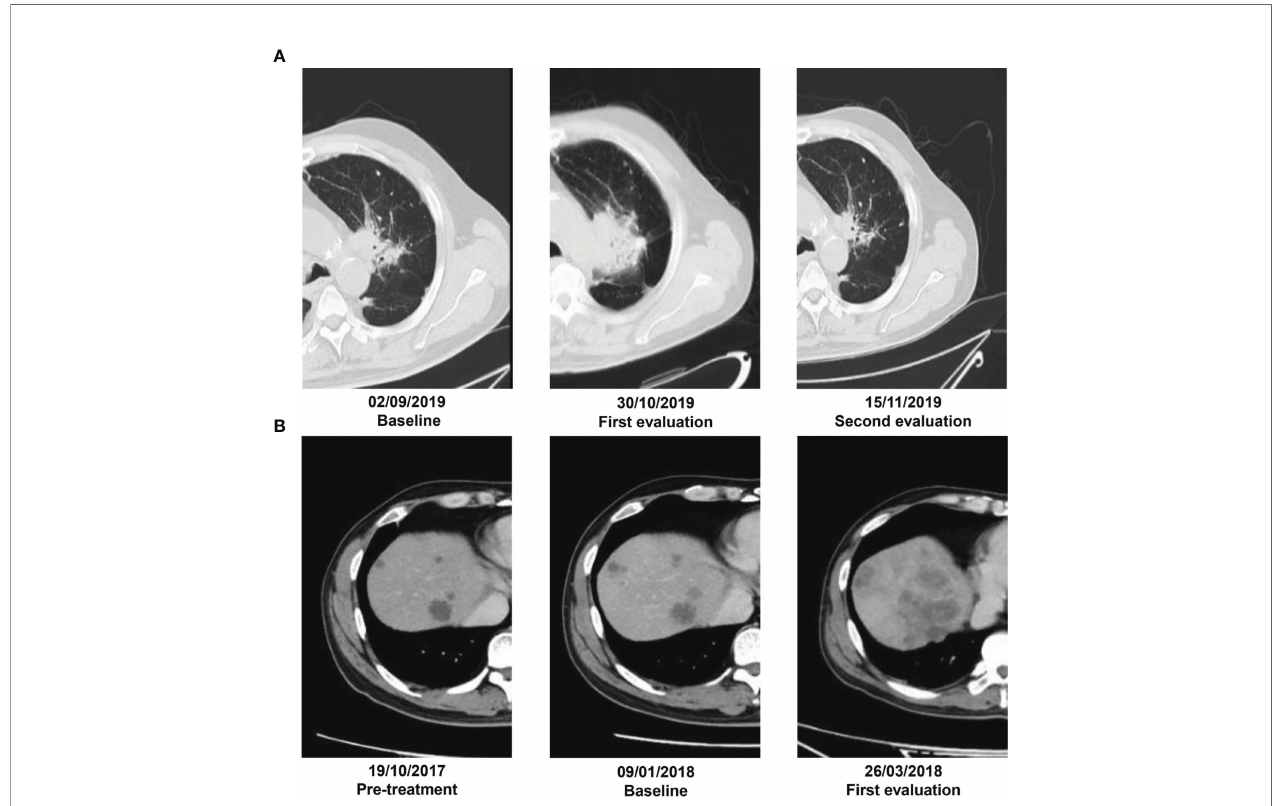
FIGURE 1 | (A) A patient with adenocarcinoma by puncture biopsy pathology who was receiving nivolumab therapy. Irregular lesion in the left upper lobe with a diameter of 3.2 cm on the baseline CT scans. By 6 weeks of anti-PD-1 therapy, the lesion increased in diameter of 5.4 cm on the fi rst CT evaluation. At 8 weeks of therapy, it had decreased in size by 2.2 cm. (B) Another 64-year-old male was treated with pembrolizumab on January 29, 2018, for liver metastasis from colorectal cancer. It had SD prior to the initiation of immunotherapy but developed rapid tumor growth with appearance of new lesions on the fi rst follow-up and experienced more than two-fold increase from pretreatment tumor growth versus